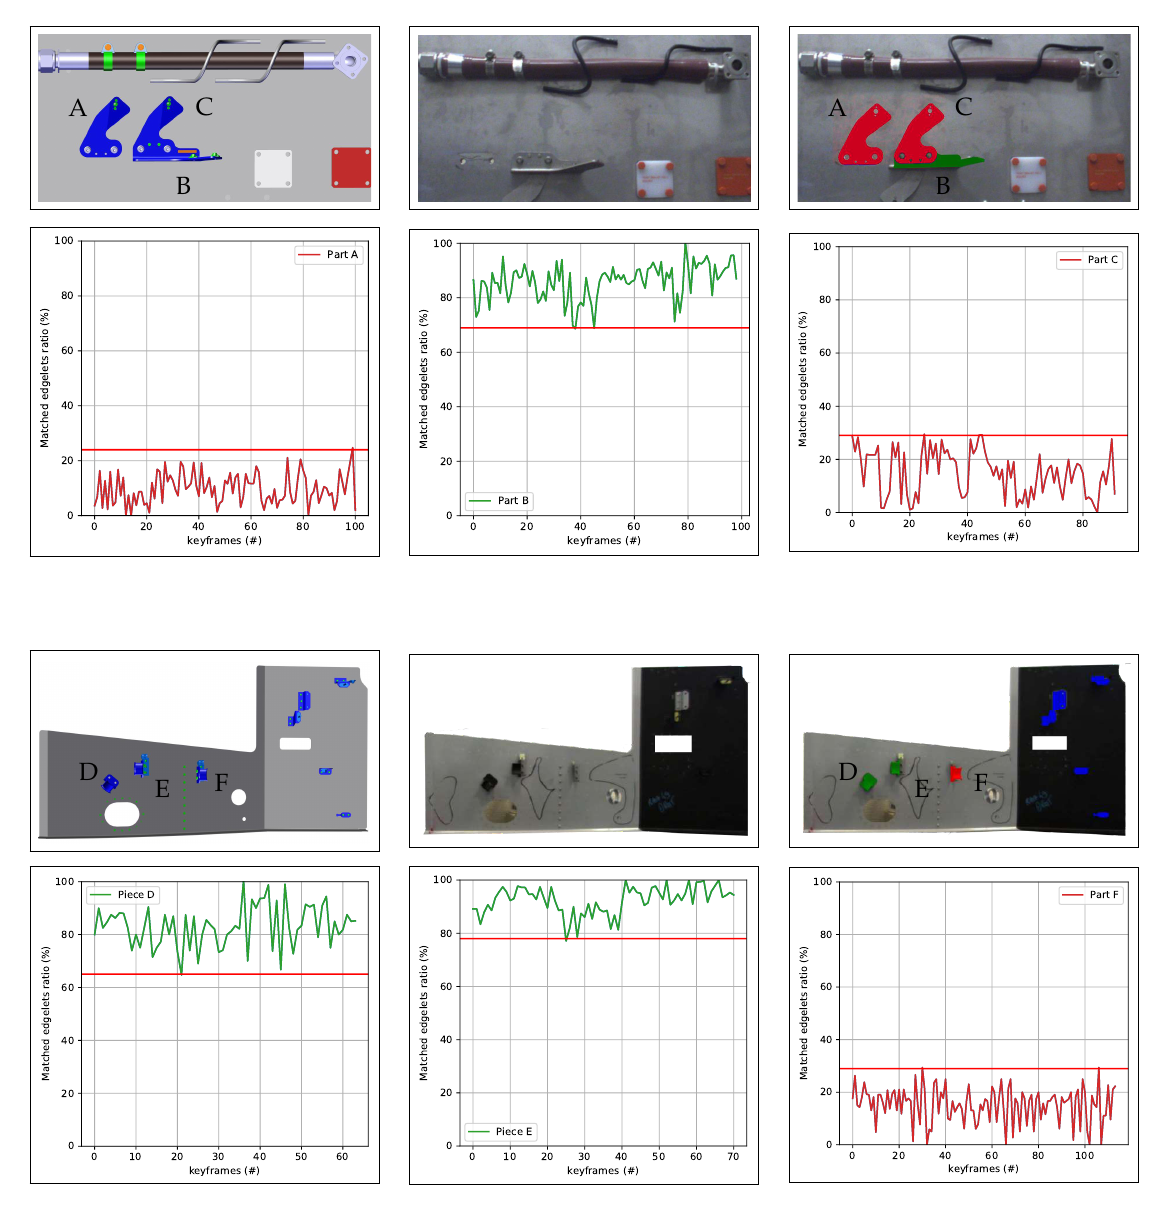
Figure 25. Experimental results for determining the optimal ratio th . The red horizontal line represents the min matched ratio in the case OK (element in green) and the max matched ratio in the case NOK (element in